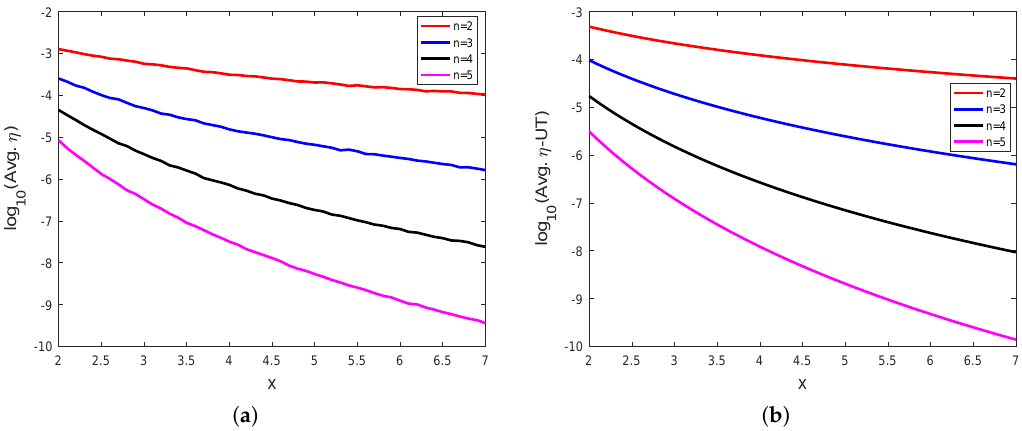
Figure 12. ( a ) Logarithm of MoN of Straka et al. (log (Avg. η )) vs. x and ( b ) logarithm of MoN of 10 Straka et al. with UT (log (Avg. η -UT)) vs. x using 10 scalar 10